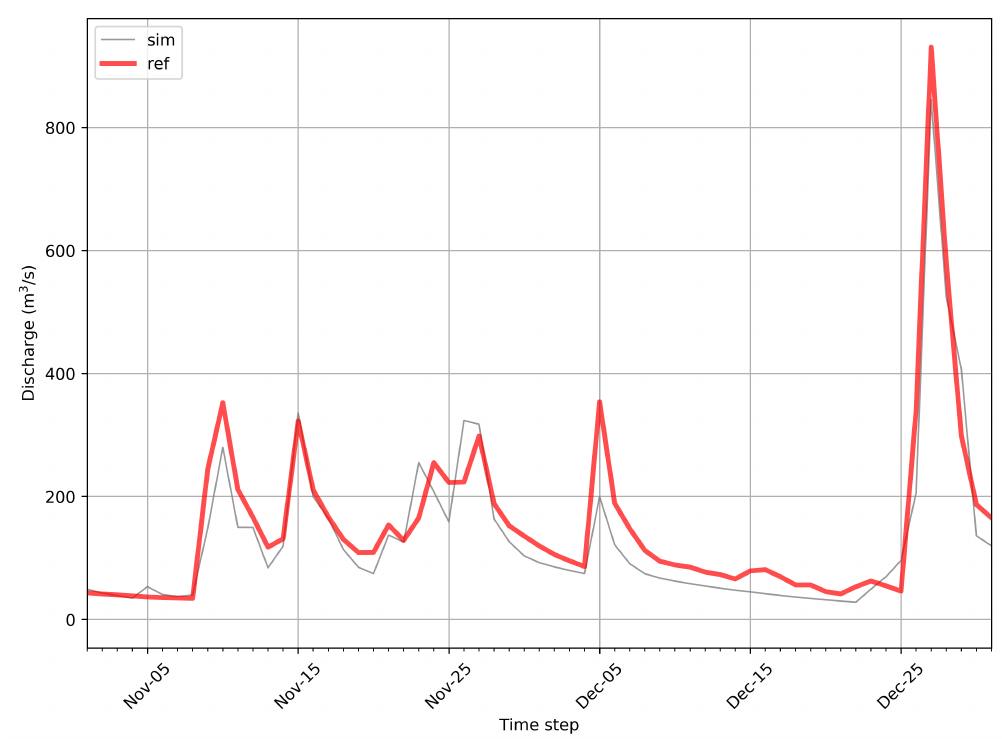
Figure 7. Observed (red) and (gray) calculated discharges for November and December 1882 using parameters from the historical period.